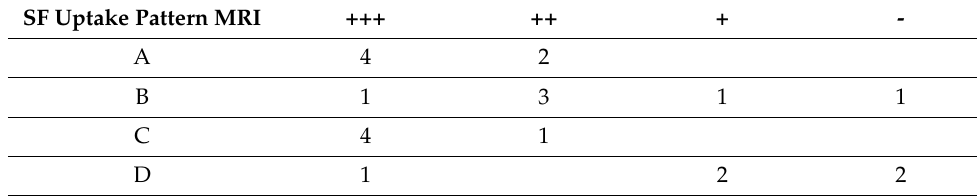
Table 2. Pattern of gadolinium enhancement and degree of intraoperative fluorescence.